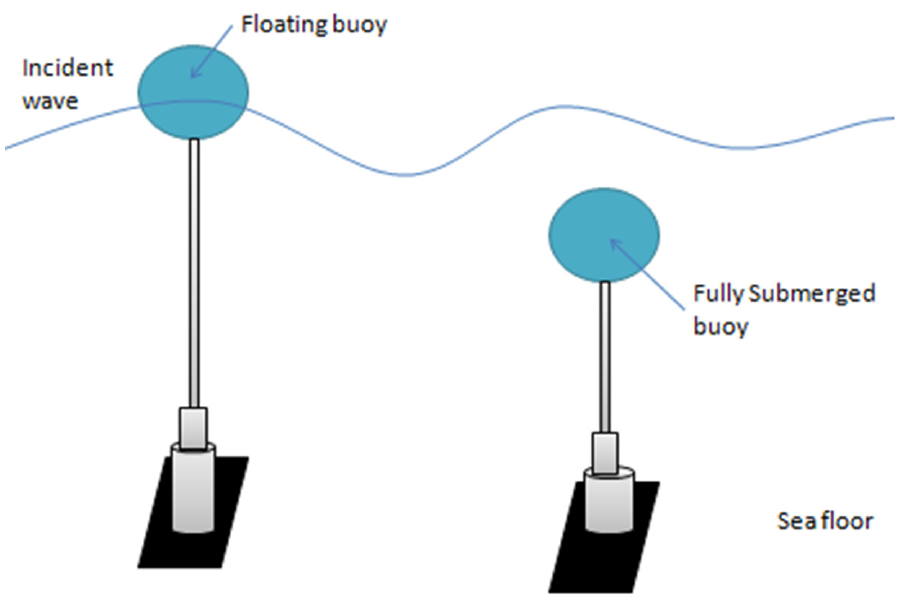
Figure 11. Two types of point absorber: submerged body and floating body.